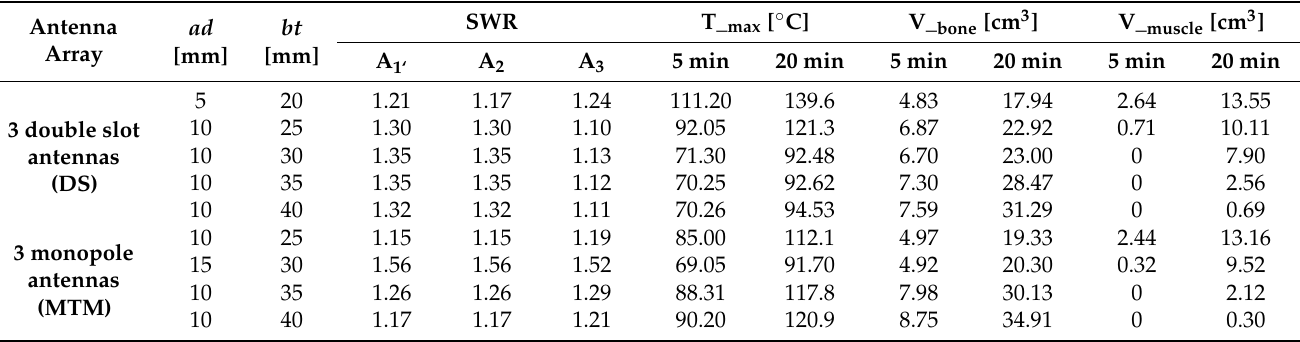
volume at temperatures higher than 55 ◦ C are presented.